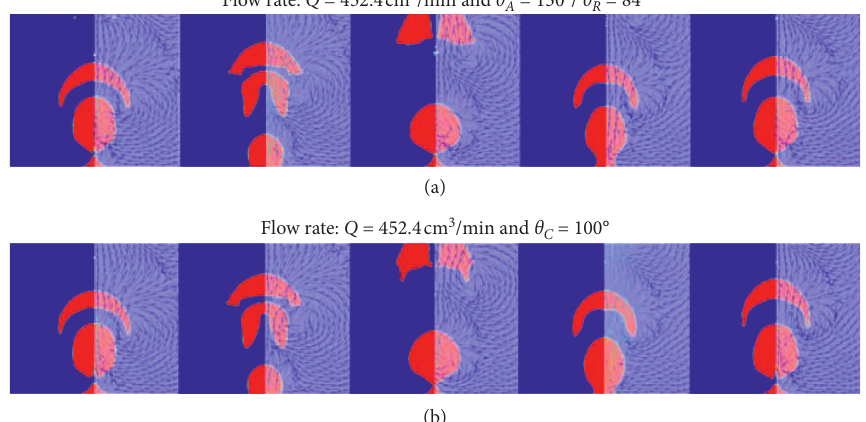
Figure 11: Comparison of flow field between dynamic and static contact angle ( Q � 452.4cm 3 /min, Re � 164.30, and d field by using the dynamic contact angle model; (b) flow field by using the static contact angle model. Snapshots 1–3: formation of the first bubble; snapshots 3–5: formation of the second bubble.